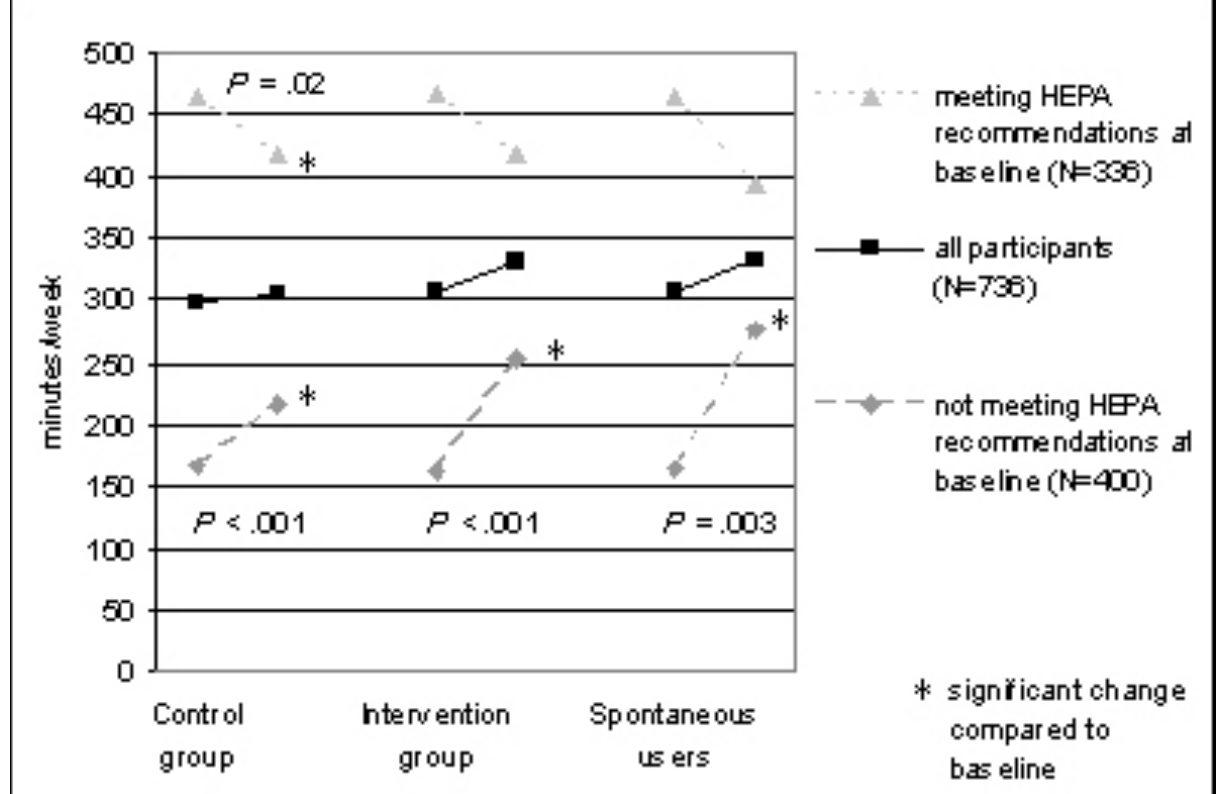
Figure 5. Changes in total reported activity time (minutes/week) between baseline and FU3 according to group, for all participants with complete data